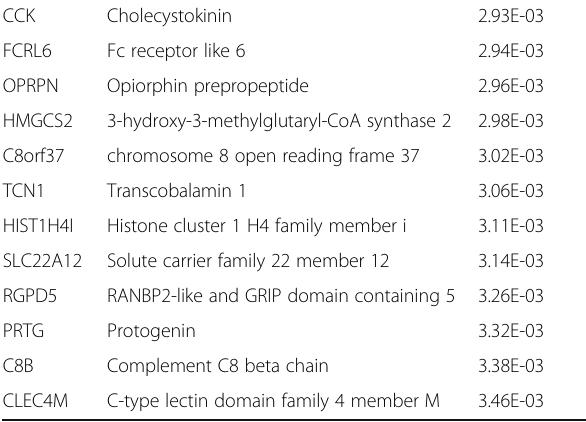
Table 3 Top 50 known genes downregulated in IIP patients Gene symbol